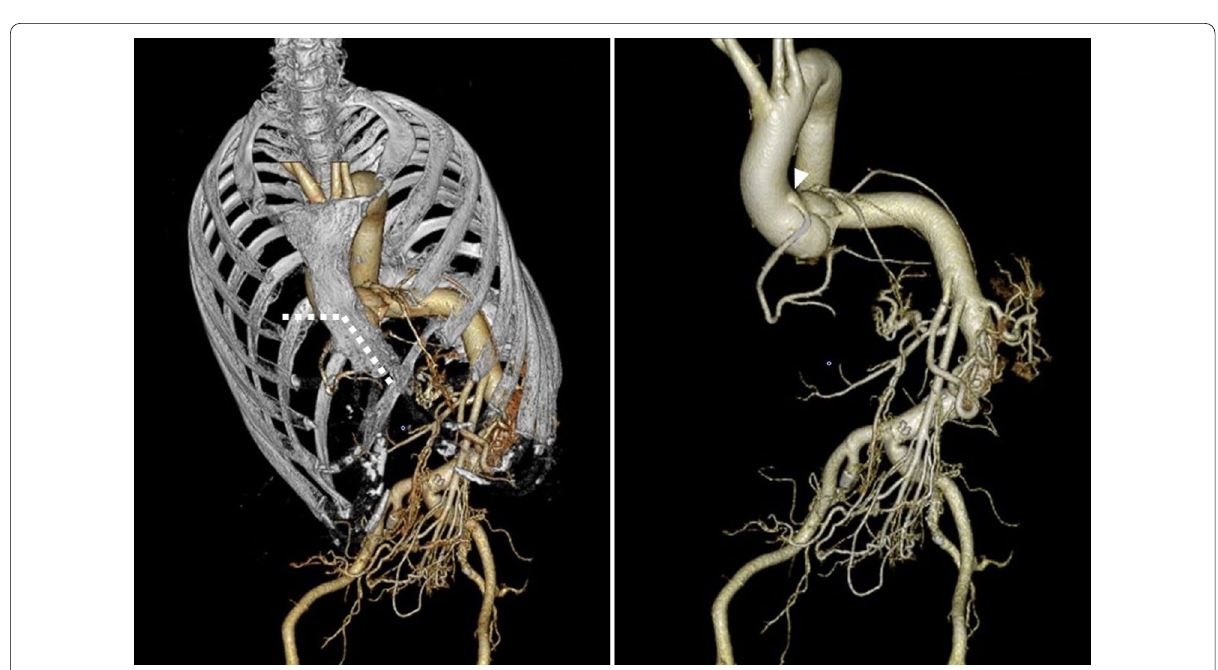
Fig. 3 Three‑dimensional reconstruction imaging showing the surgical incision line for lower hemisternotomy (white dotted line). The right coronary artery arises from the anteromedial surface of the ascending aorta (white